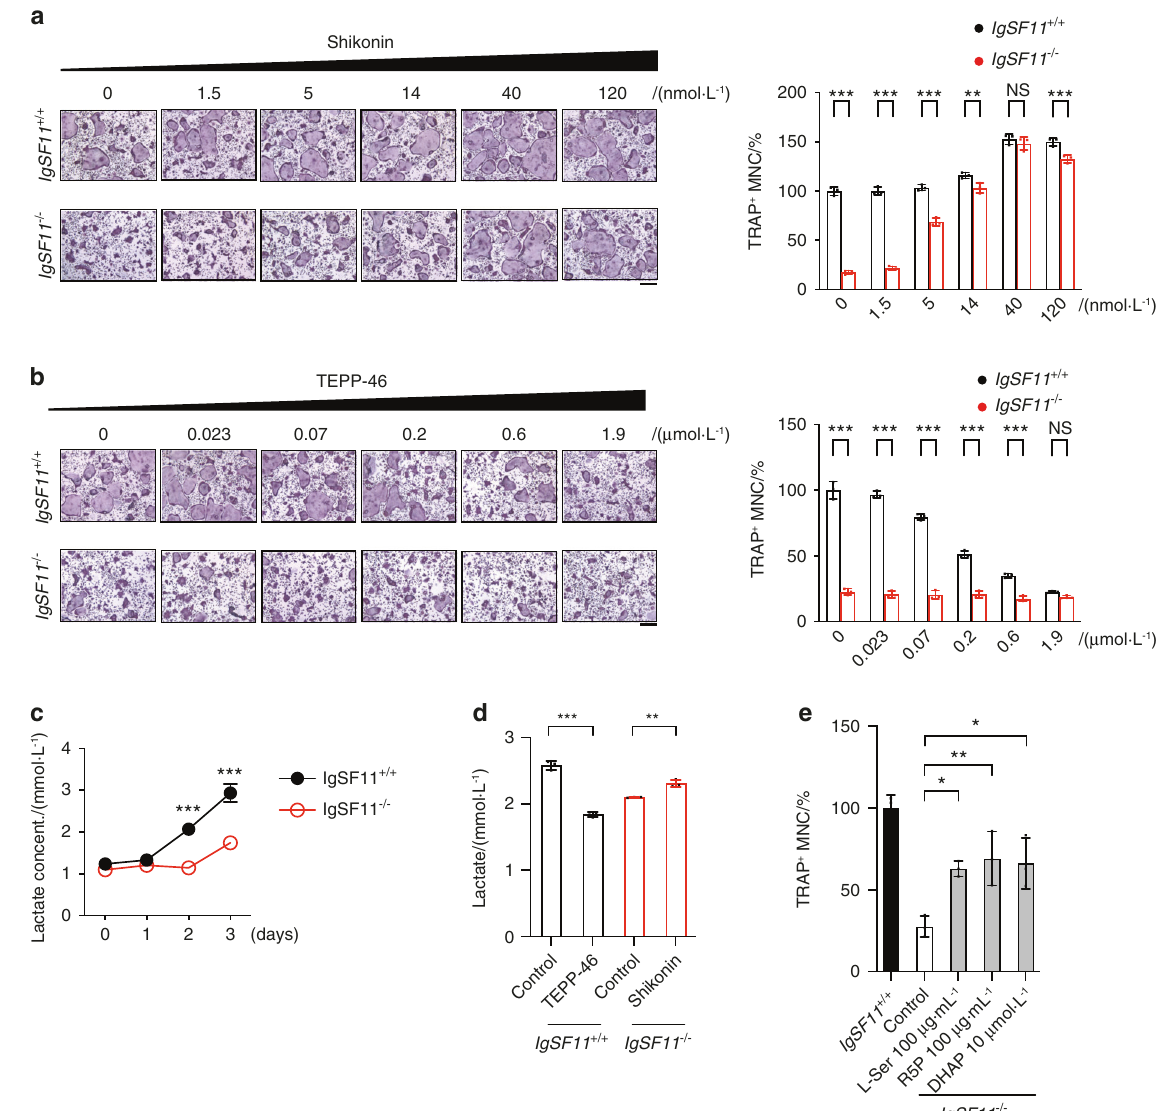
Fig. 3 The inhibition of PKM2 activity by IgSF11 is required for osteoclast differentiation. a Effect of shikonin on osteoclast differentiation. IgSF11 + / + and IgSF11 − / − BMMs were cultured with M-CSF + RANKL for three days. The indicated dose of shikonin was added and incubated for three days. b Effect of TEPP46 on osteoclast differentiation. IgSF11 + / + and IgSF11 − / − BMMs were cultured with M-CSF + RANKL for three days. The indicated dose of TEPP46 was added and incubated for three days. TRAP staining and the frequency of TRAP + multinucleated cells (3 nuclei or more per cell) are shown. Scale bars represent 100 μ m. c Lactate production during osteoclast differentiation. IgSF11 + / + and IgSF11 − / − BMMs were cultured with M-CSF + RANKL for three days. The lactate concentration in the culture supernatants was measured daily. d Lactate production in response to the modulation of PKM2 activity. IgSF11 + / + and IgSF11 − / − BMMs were cultured with M-CSF + RANKL for three days. Control DMSO or TEPP46 was added to IgSF11 + / + cultures and incubated for three days. Control DMSO or shikonin was added to IgSF11 − / − cultures and incubated for three days. The lactate concentrations in the culture supernatants were measured. e Effect of glycolysis intermediates on osteoclast differentiation. IgSF11 + / + and IgSF11 − / − BMMs were cultured with M-CSF + RANKL for three days. The indicated dose of glycolysis intermediates was added to IgSF11 − / − cultures and incubated for three days. IgSF11 + / + cultures were used as a control. The frequency of TRAP + multinucleated cells (3 nuclei or more per cell) is shown. The data are presented as the means ± S.D. Each dot represents a technical replicate. The results are representative of at least three independent added to IgSF11 − / − cultures during osteoclast differentiation, osteoclast differentiation was partially but signi fi cantly restored (Fig. 3e). These results suggest that IgSF11-mediated negative regulation of PKM2 contributes to osteoclast differentiation by shunting glucose metabolites toward anabolic pathways.